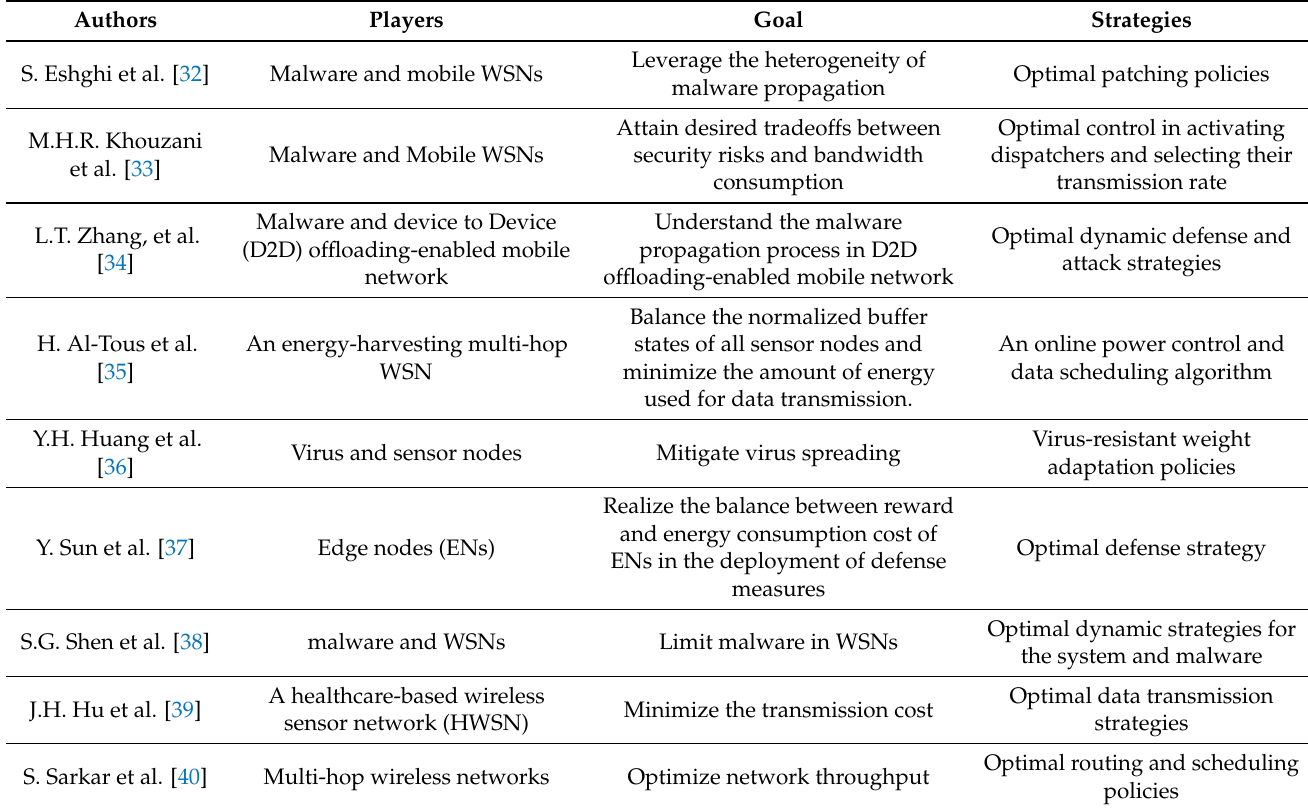
Table 3. Research on differential game applied in